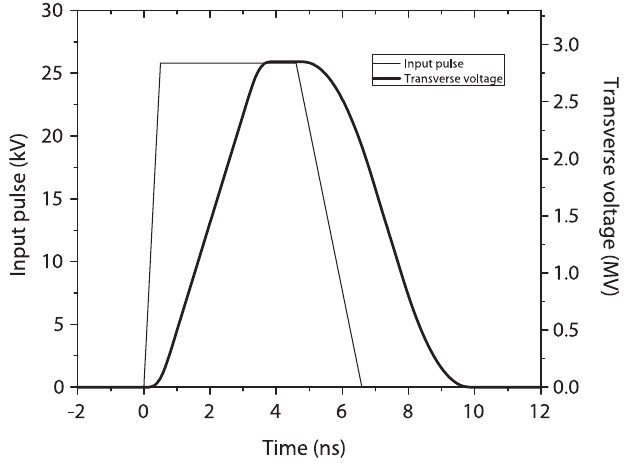
FIG. 9. Transverse voltage and input pulse for the 0.5 m long kicker with tapering (the last row of